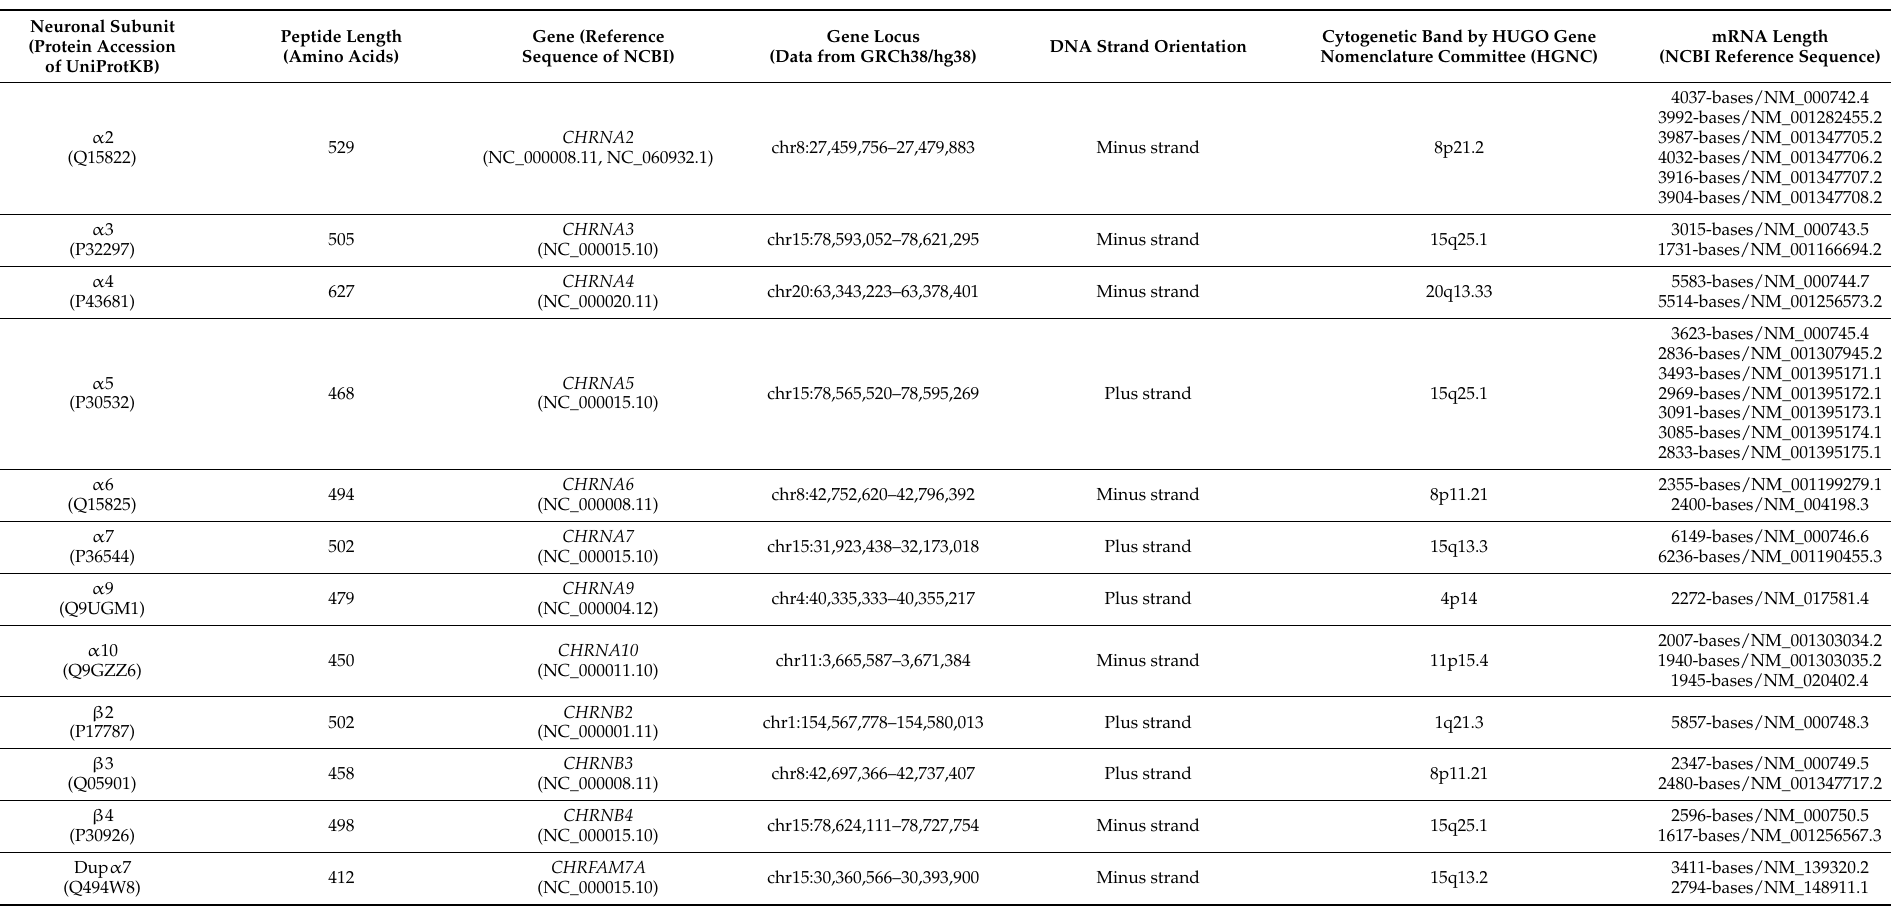
Table 1. Detailed information for the reference sequences (genomic DNA, mRNA transcripts and proteins, genomic DNA locations, protein and mRNA lengths of subunits of human neuronal nAChRs). All data are generated from the GeneCards database (https://www.genecards.org/ (accessed on 5 December